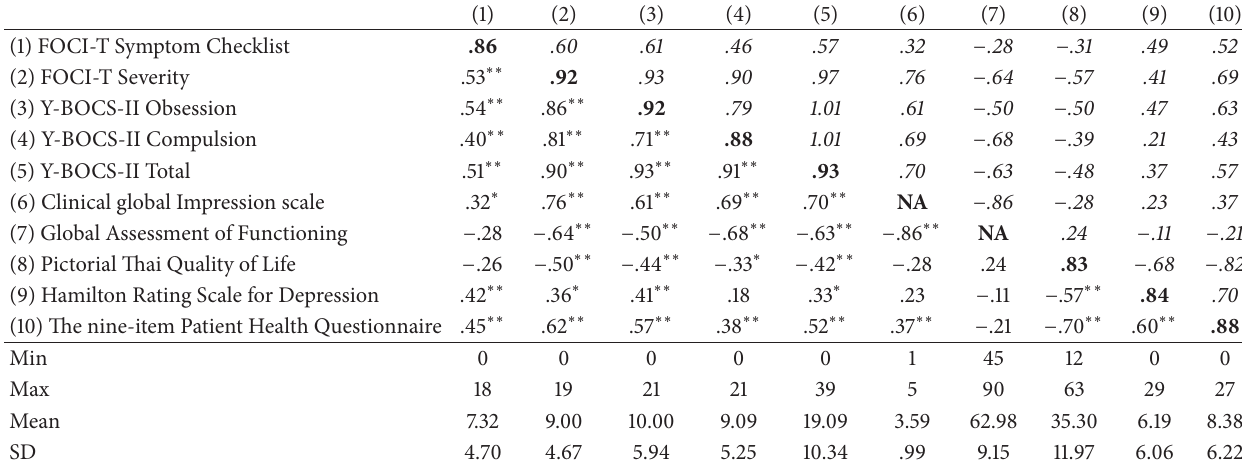
Table 2: Correlations between the FOCI-T and other measures of OCD, depression, and quality of